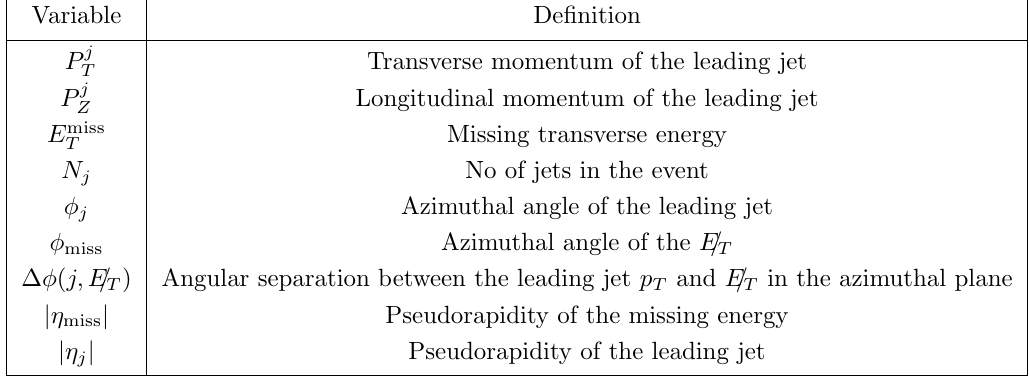
Table 7 . Input variables for XGBoost and ANN analysis for gluon fusion. Azimuthal angles are measured with reference to some arbitrary x -axis.